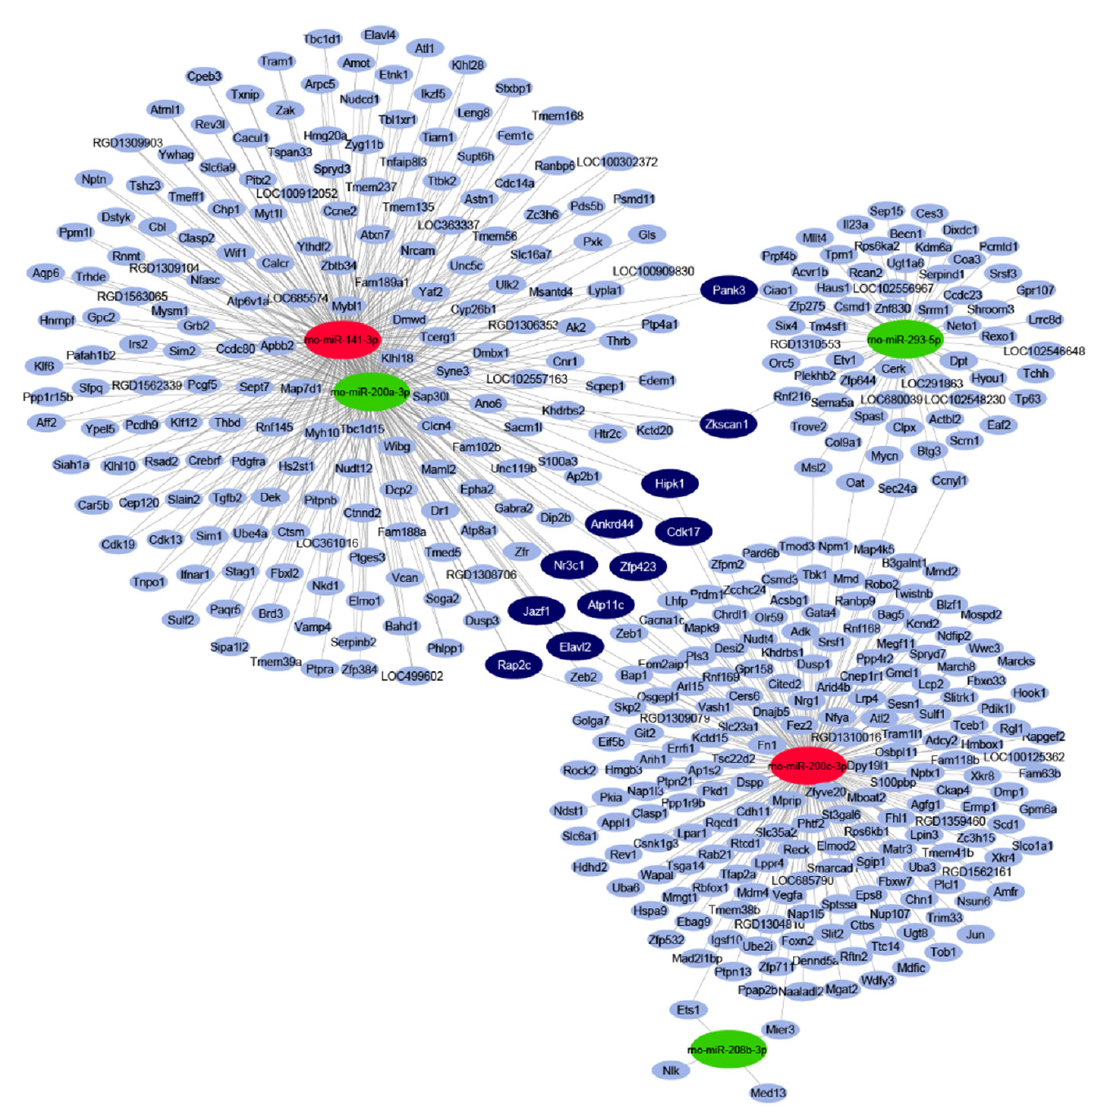
Figure 1. Interaction network and miRNA target prediction analysis of downregulated miRNAs (green) and upregulated miRNAs (red). mRNAs with less than three miRNA interactions are indicated in light-blue colour. mRNAs targeted by three differentially expressed miRNAs are indicated in dark-blue colour.